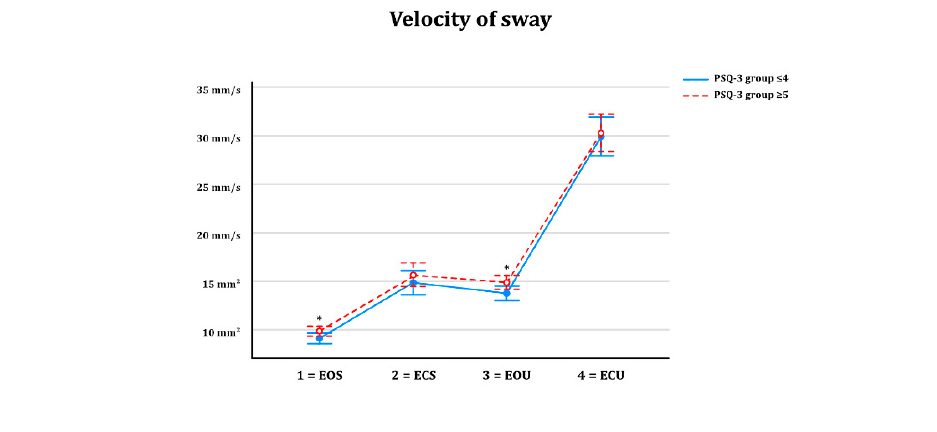
Figure 2. Postural control on PSQ-3-FI groups score ≤ 4 or ≥ 5 groups ( n = 229).